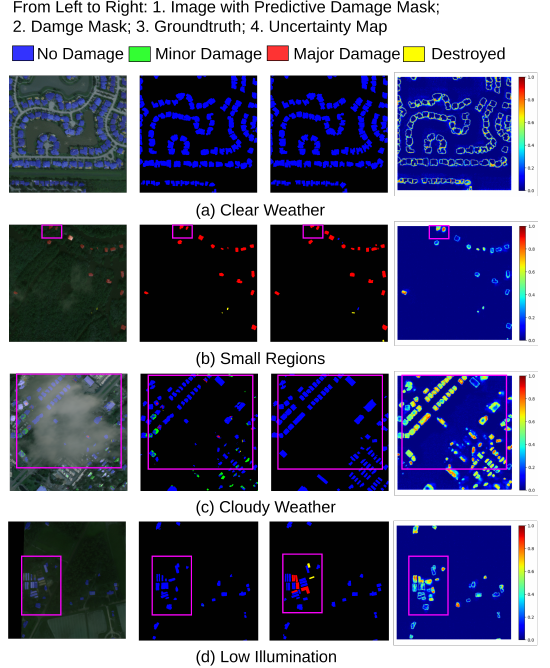
Figure 9. The case studies of robust operation. The pink box indicate where the experts pay attention for further investigation on the